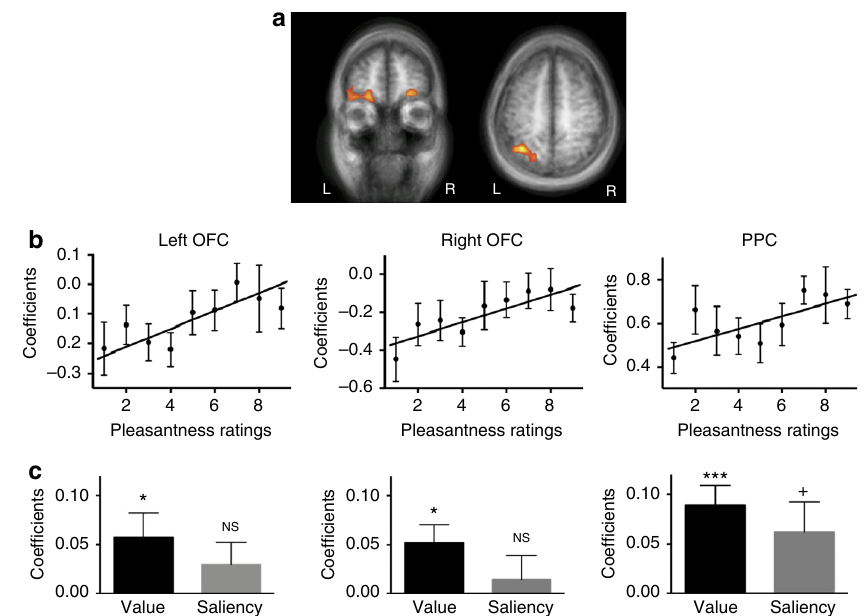
Fig. 2 Univariate value signals in the brain. a BOLD activity of the bilateral OFC and the left PPC signi fi cantly correlated with cue value (per-voxel p < 0.005 and cluster-size thresholding at FWE p < 0.05). b Activity levels in these regions showed a positive slope on value (pleasantness ratings). Data were extracted from ROIs de fi ned by a LOSO procedure ( n = 18). c The effects of value and saliency on the activity of these brain regions were assessed in the same ROIs generated by the LOSO procedure, using a GLM with both value and saliency parametric regressors. Bilateral OFC demonstrated speci fi city to value, while PPC also showed a mild saliency effect. OFC orbitofrontal cortex. PPC posterior parietal